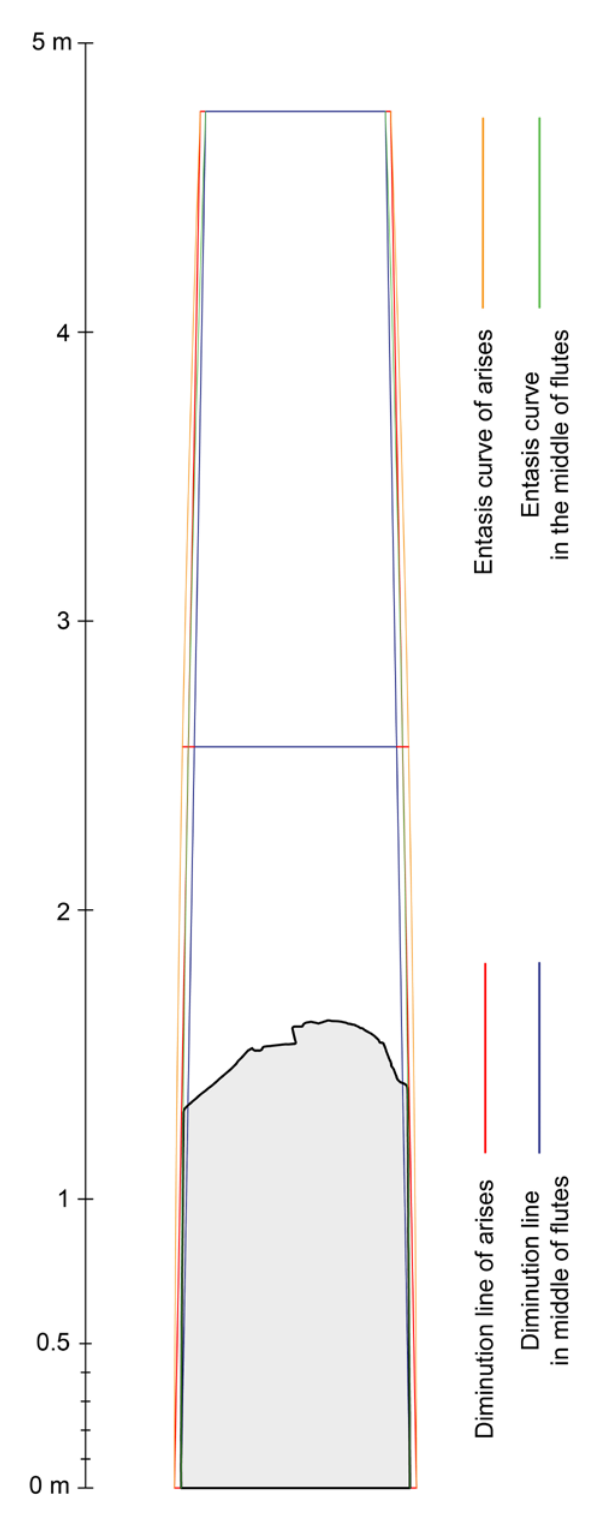
Figure 5.Section of the column drum along the axis crossing the middle of two diametrical flutes, which shows that the diminution line is not followed. Instead it corresponds with the proposed entasis